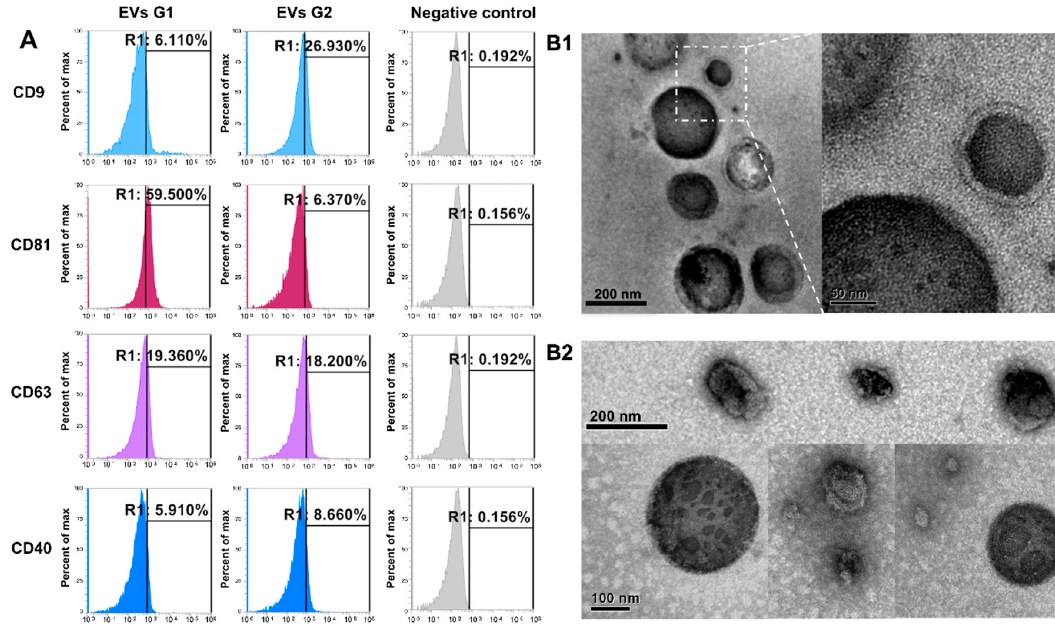
Figure 1. Characterization of extracellular vesicles (EVs) secreted by early bovine embryos with different developmental potential. ( A ) Flow cytometry analysis of EVs markers (CD9, CD63, CD81, and CD40) in EVs secreted by embryos arrested in the 8–16-cells stage (G1) and EVs secreted by embryos that reached blastocyst stages at day 7 (G2). Negative control: beads without EVs and incubated with antibodies against each marker. ( B ) Representative images from transmission electron microscopy (TEM) showing EVs in medium secreted by embryos arrested in the 8–16-cells stage ( B1 ) and by embryos that reached blastocyst stages at day 7 ( B2 ).